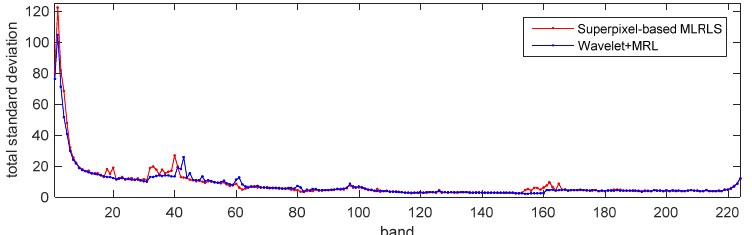
estimated by the superpixel ‐ based MLRLS and k T